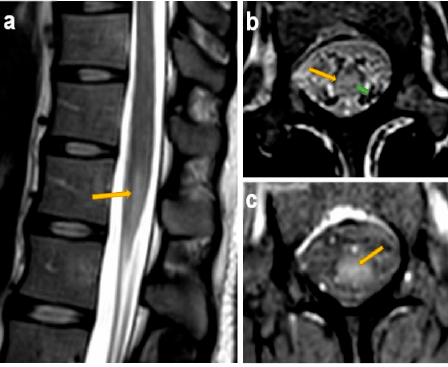
Figure 1. Magnetic resonance imaging of the lumbosacral spine. Sagittal ( a ) and axial ( b ) T2 weighted showing enhancement (yellow arrows), and axial T1-weighted sequence ( c ), showing contrast enhancement of the medullary cone. Panel ( b ) also displays sparing of some nerve bundles (green arrow).